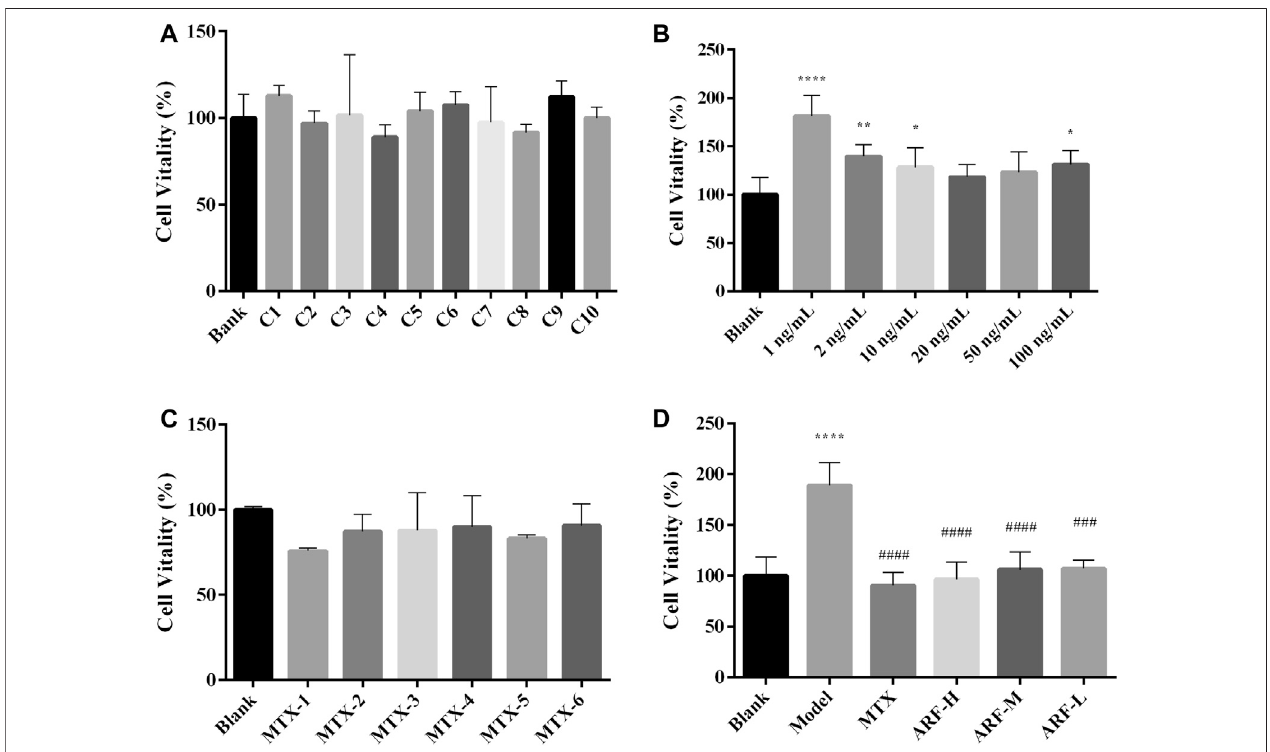
FIGURE 8 | Effects of ARF and MTX on cell viability of HFLS-RA with or without IL-1 β stimulation. (A) : HFLS-RA cultured with different concentration (3.3252 – 0.0065 mg/ml) of ARF for 48 h. (B) : IL-1 β -induced proliferation in HFLS-RA were investigated after culturing 48 h. (C) : HFLS-RA incubated with six concentrations of MTX for 48 h. (D) : IL-1 β -stimulated HFLS-RA were treated with ARF-H (1.6626 mg/ml), ARF-M (0.4157 mg/ml), ARF-L (0.0519 mg/ml) or MTX (1 × 10 − 5 μ M) for 48 h. Results are showed as mean ± SD ( n (cid:1) 6). Cell viability was monitored by MTT assay. Blank group represents the cells without drug treatment. * p < 0.05, ** p < 0.01, **** p < 0.001, versus Blank group; ### p < 0.005 and #### p < 0.001, versus IL-1 β -stimulated group (Model